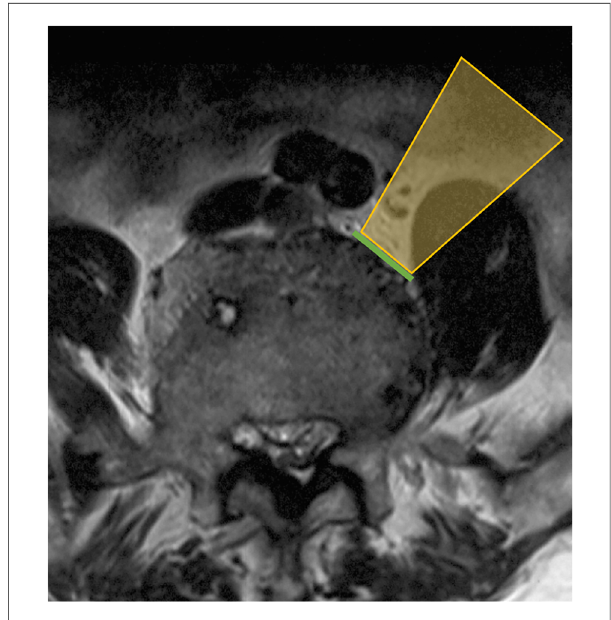
FIGURE 1 Ideal oblique corridor accessing to intervertebral disc may be blocked by hypertrophic belly of psoas (note the orange area). Green line indicates ideal OLIF